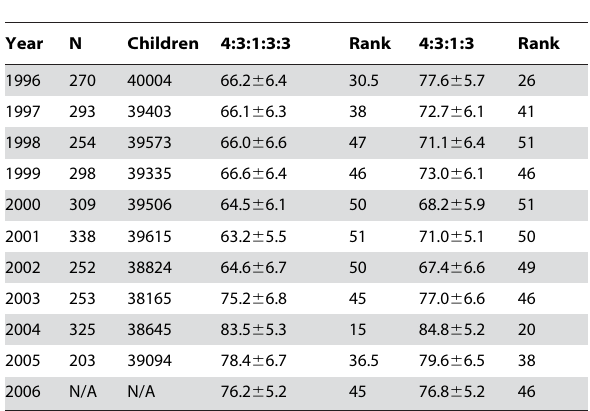
Table 1. National Immunization Survey (NIS), sample sizes (N), estimated number of children 9–35 months of age, and annual estimates of coverage and national ranking for